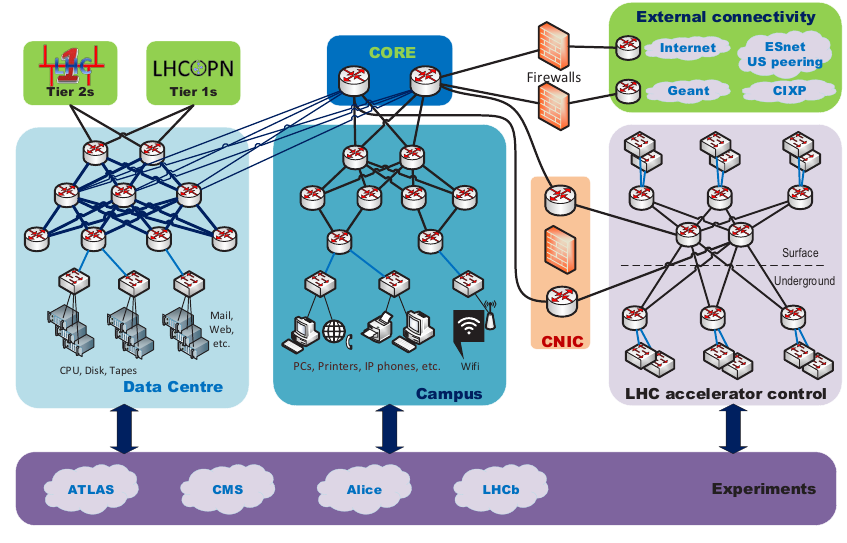
Figure 1: CERN networks